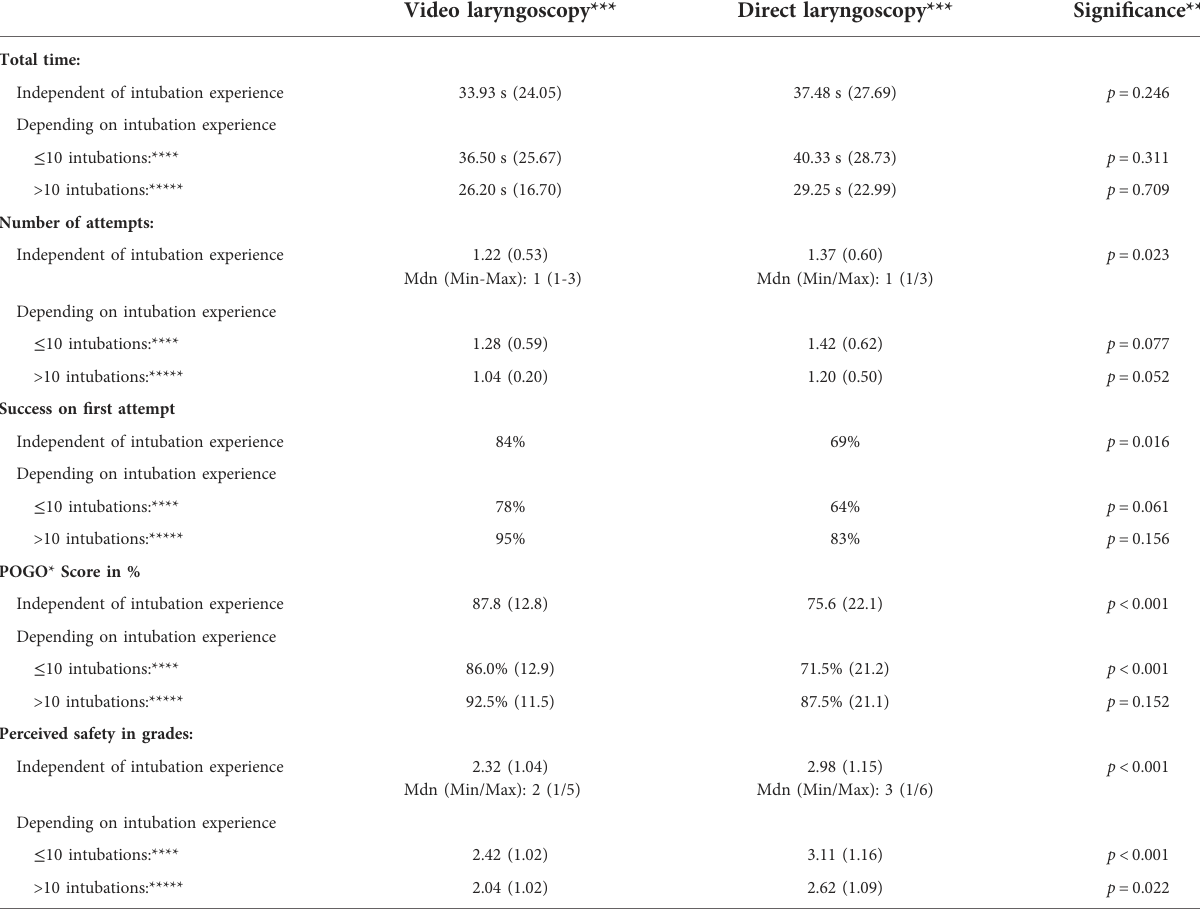
TABLE 1 Overview of the primary and secondary study results.